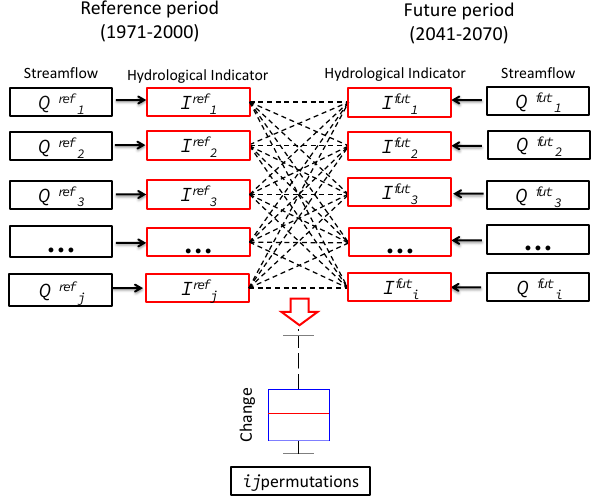
Fig. 4. Schematic representation of the permutation process.